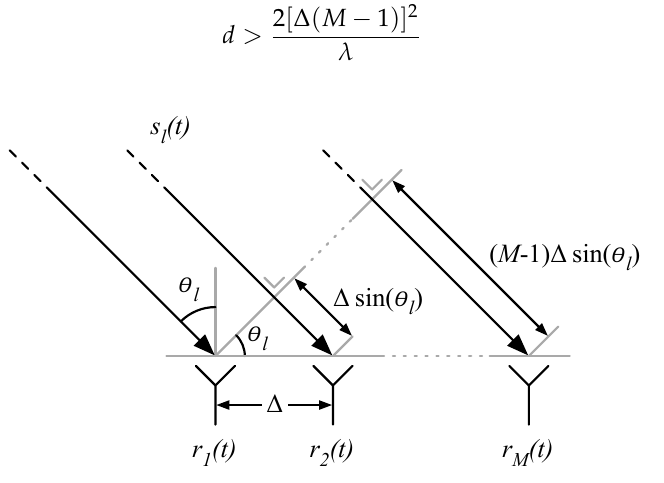
Figure 2. ULA system